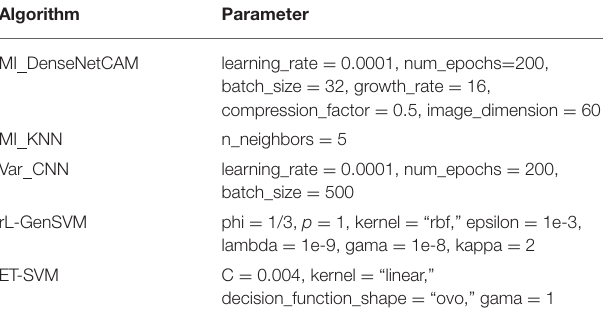
TABLE 1 | Parameter settings. Algorithm